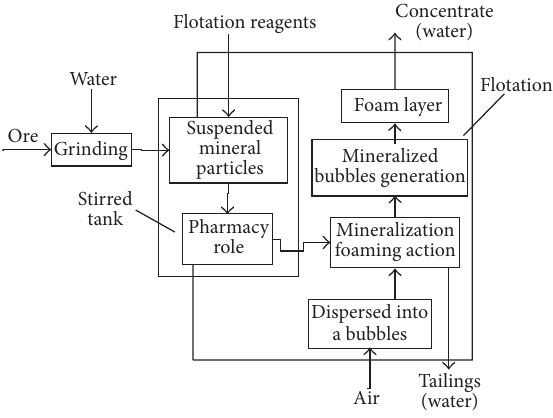
Figure 1: Basic technique diagram of flotation